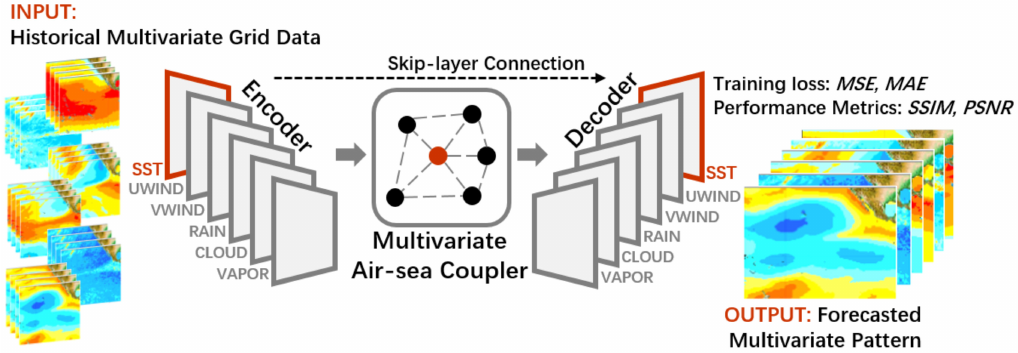
Figure 11. The structure of ENSO-ASC